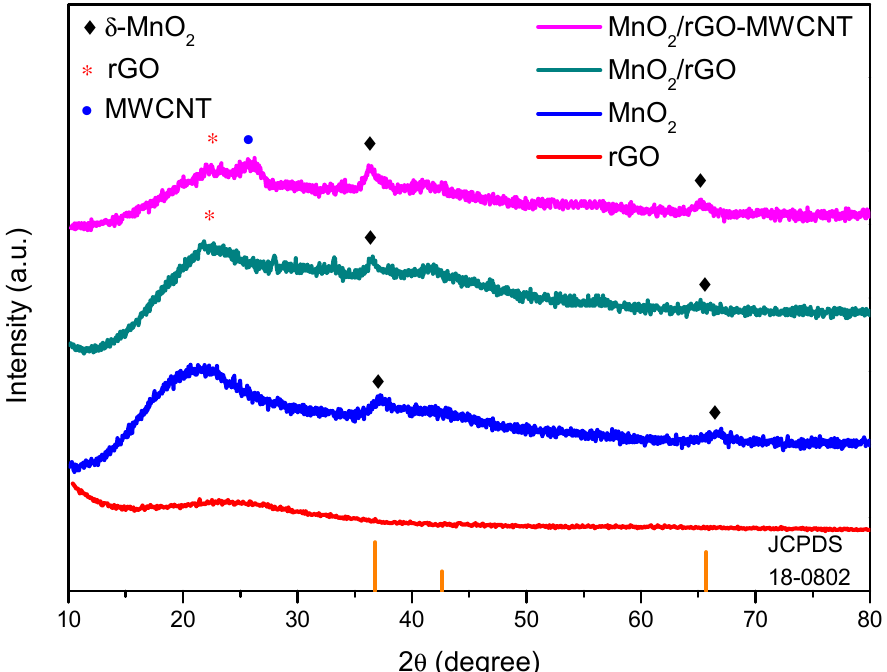
Figure 2. The X-ray diffraction (XRD) analysis for the MnO 2 -based electrode materials prepared by the successive ionic layer adsorption and reaction (SILAR) process.